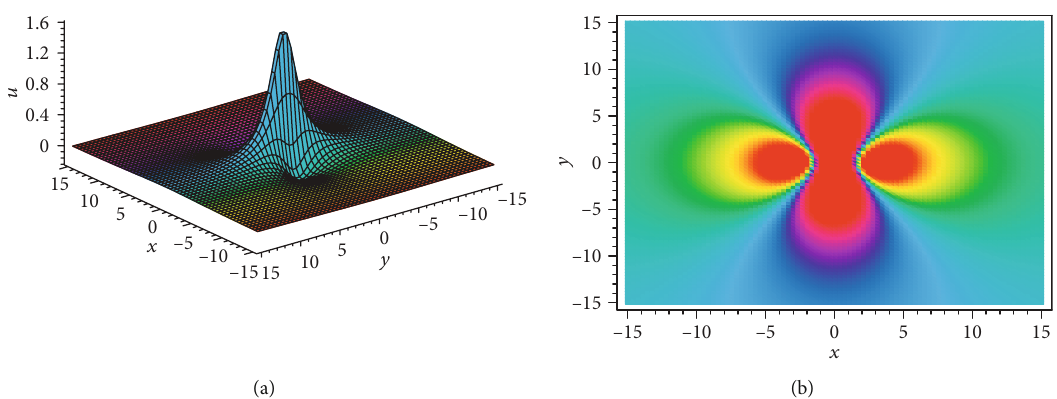
Figure 3: (a) The three-dimensional plot of a lump wave of the ð 2 + 1 Þ -dimensional higher-order Boussinesq equation with the parameters in (18). (b) The corresponding density